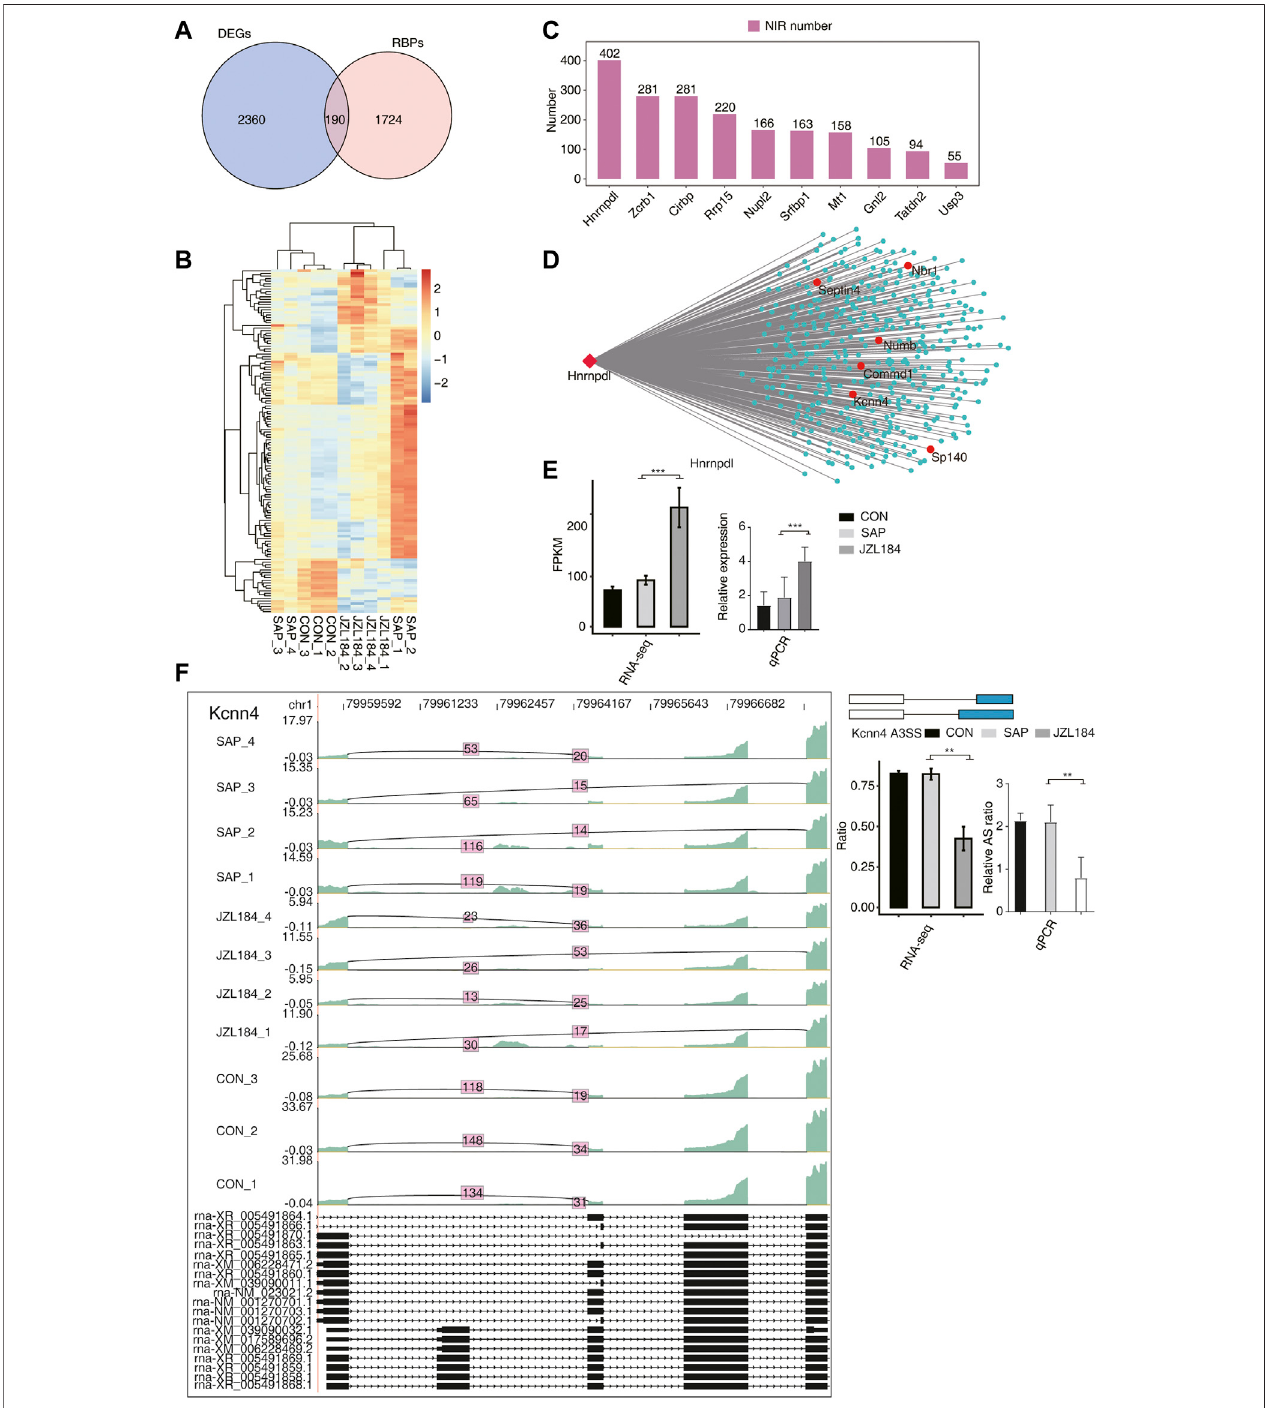
FIGURE6 | Co-expressionanalysisbetweenMAGLinhibitorregulatedRBPswithNIRinintestinaltissueofratswithSAP. (A) Venndiagramshowingtheoverlappedgenes betweenRBPsandDEGs; (B) Hierarchicalclusteringheatmapshowingtheexpressionlevelsoftheoverlappedgenesin (A) .Signi fi cantdifferencesintheexpressionlevelsofthese RBPswerefoundamongthegroups(ShowexpressionFPKMgreaterthan1in80%ofthesamples); (C) BarplotshowingthenumberofNIRexpressedshowingthetop10RBPs sorted bythenumberofRBPsco-expressedfromtheabovescreenedRBPs; (D) Co-expressionnetworkbetween NIRsand Hnrnpdlgene.TheseRBPswerespeci fi cally and highly expressed in theJZL184 group, in which the ASEs co-expressed by HNRNPDL comprised the most, which reached 402 ASEs; (E) Bar plot showingthe expression patternandstatisticaldifferenceofDEGsforHnrnpdlgene.Errorbarsrepresentmean±SEM;*** p -value < 0.001. (F) MAGLregulatesalternativesplicingofKcnn4.Leftpanel:IGV- sashimiplotshowingtheregulatedalternativesplicingeventsandbindingsitesacrossmRNA.ReadsdistributionofRASEisplottedintheuppanelandthetranscriptsofeachgene areshownbelow.Rightpanel:TheschematicdiagramsdepictthestructuresofASEs.RNA-seqvalidationofASEsareshownatthebottomoftherightpanel.Errorbarsrepresent mean ± SEM. *** p -value < 0.001, ** p -value < 0.01, * p -value < 0.05. n = 3 in control group. n = 4 in SAP group and JZL184 group.